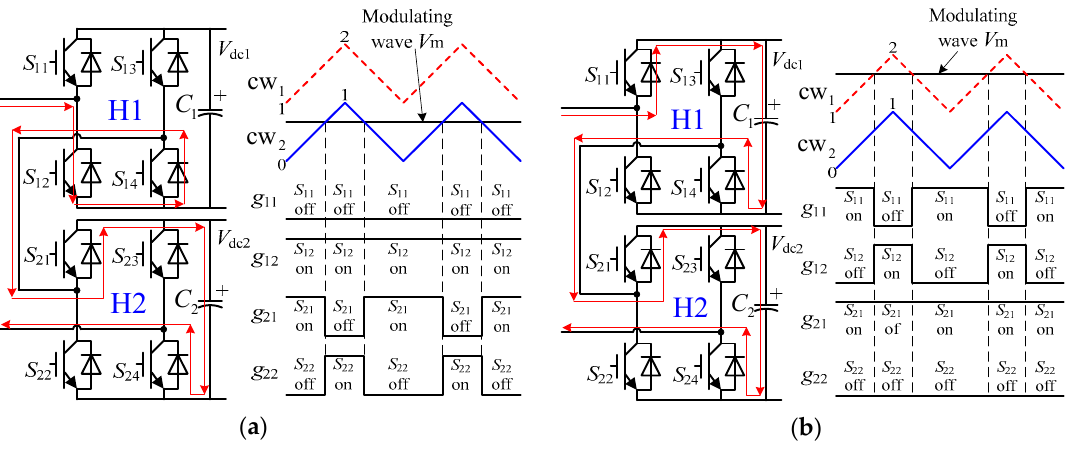
Figure 3. Principle of improved PD-PWM for DC-link voltage balancing of cascaded H-bridge rectifiers ( I dir > 0). ( a ) Modulating wave during [0, 1]; ( b ) Modulating wave during [1, 2].